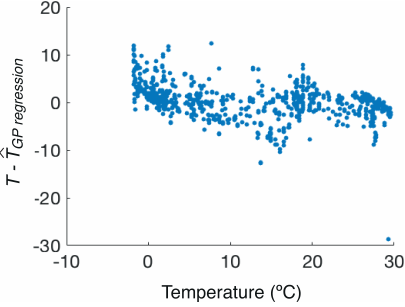
Figure 5. The error of the GPR (Gaussian process regression) pre- dictor as a function of the true temperature.